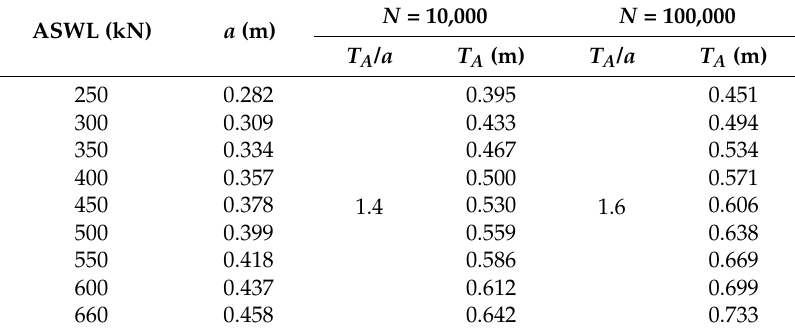
Table 3. Data to draw ASWL curves for 10,000 and 100,000 yearly passes.